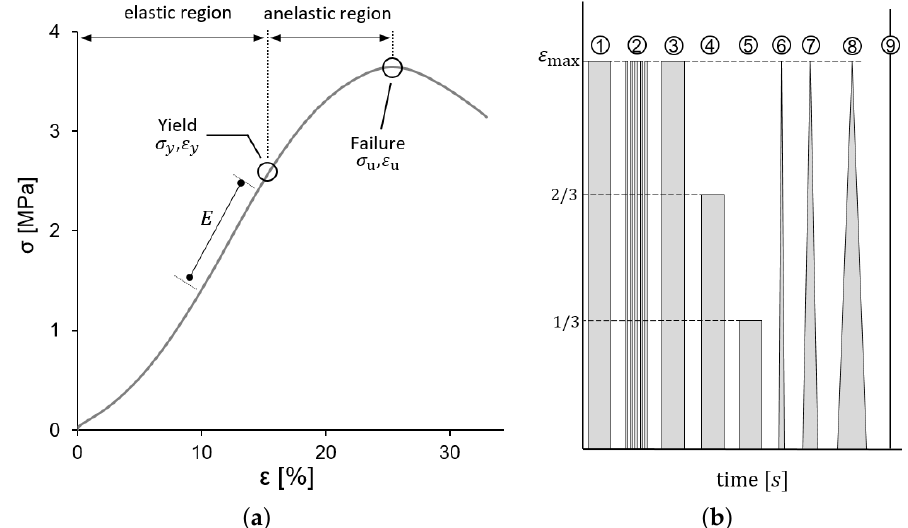
Figure 2. ( a ) Typical Stress–Strain curve obtained for CBVs showing the characteristics determined; these parameters were proposed in [20] and subsequently used also in [3,9]. ( b ) The scheme of the different stages of the testing procedure (relaxation, cyclic loading and loading-unloading